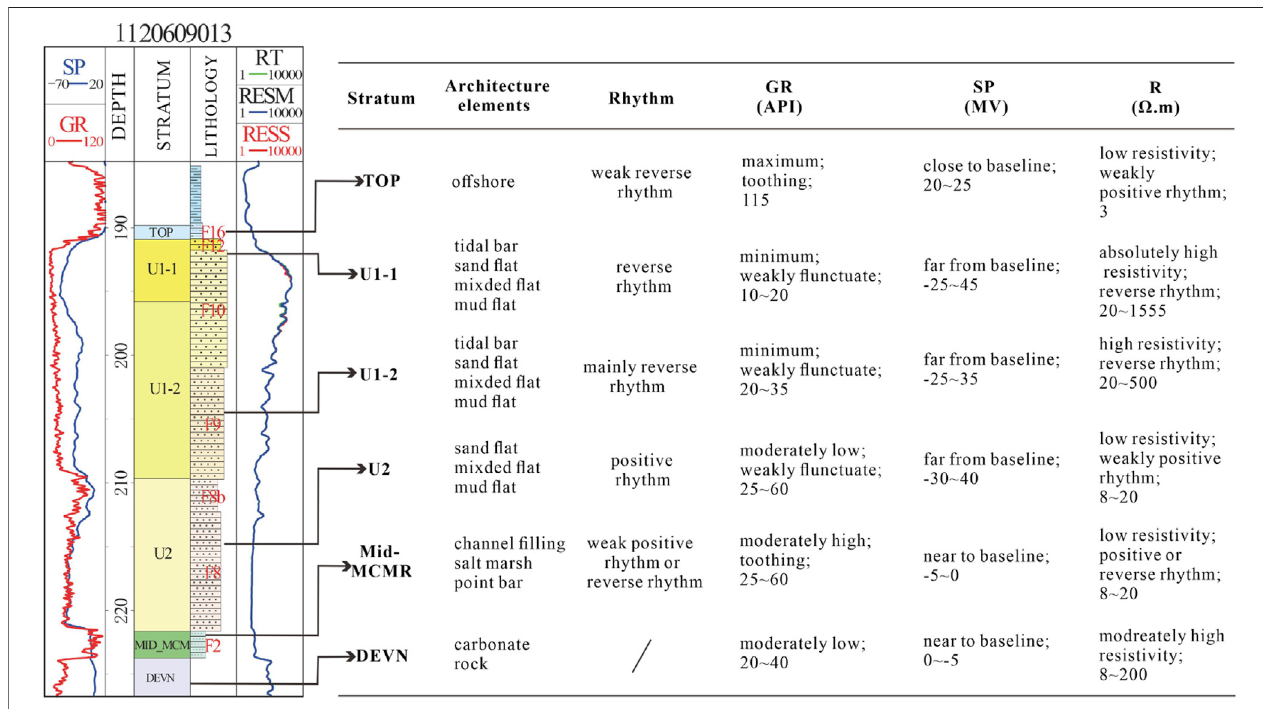
FIGURE 3 | The relationship of logging data and architecture